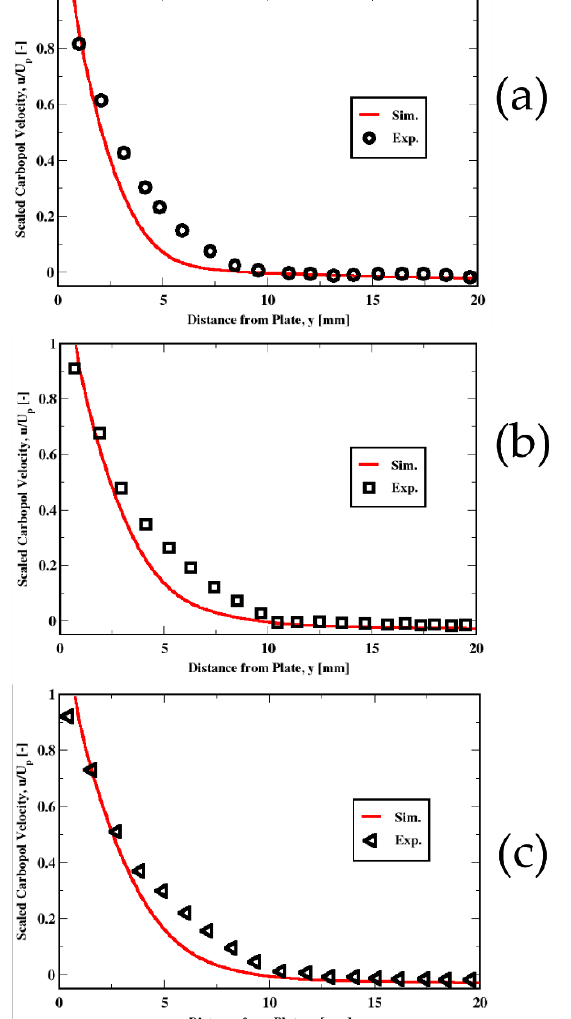
Figure 6. Distribution of the velocity of the Carbopol fluid. Plots from top ( a ), middle ( b ), and bottom ( c ) refer to the immersion velocities of 1 mm/s, 3 mm/s, and 5 mm/s, respectively.